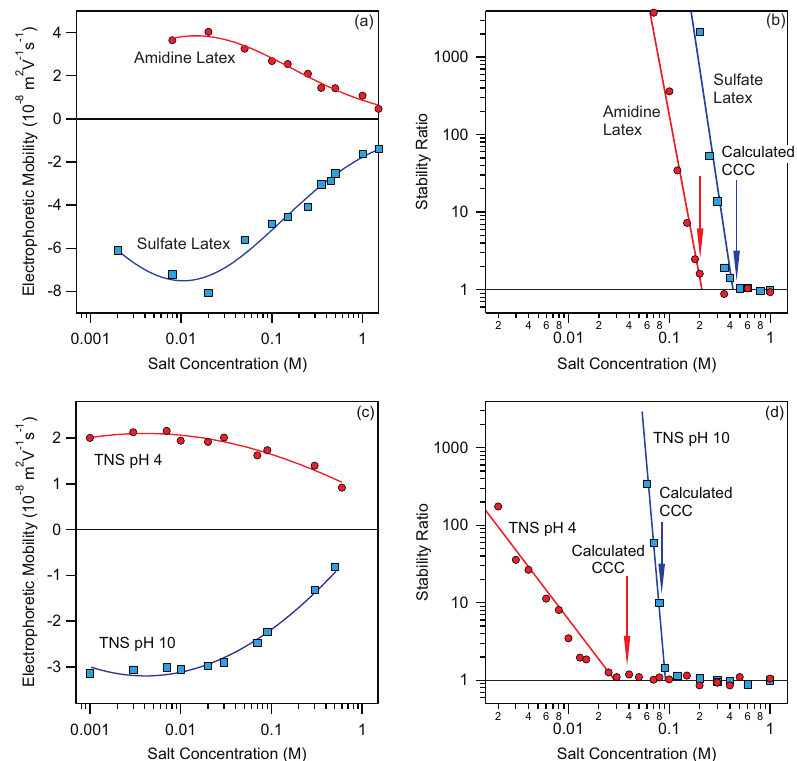
Figure 1. ( a ) Electrophoretic mobility as a function of NaCl concentration for amidine and sulfate latex particles. The lines show the interpolating curves used for CCC calculation. ( b ) Stability ratios as a function of NaCl concentration for amidine and sulfate latex. Measurements were done at pH 4.0. Data were taken from [35]. The arrows mark the calculated CCC values based on Hamaker constant of 9.0 · 10 − 21 J. The lines connecting the stability data points are eye-guides. ( c ) Electrophoretic mobility as a function of NaCl concentration for titania nanosheets (TNS) at pH 4.0 and 10. The lines show the interpolating curves used for CCC calculation. ( d ) Stability ratios as a function NaCl concentration. Data were taken from [49]. The arrows mark the calculated CCC values based on Hamaker constant of 1.7 · 10 − 20 J. The lines connecting the stability data points are